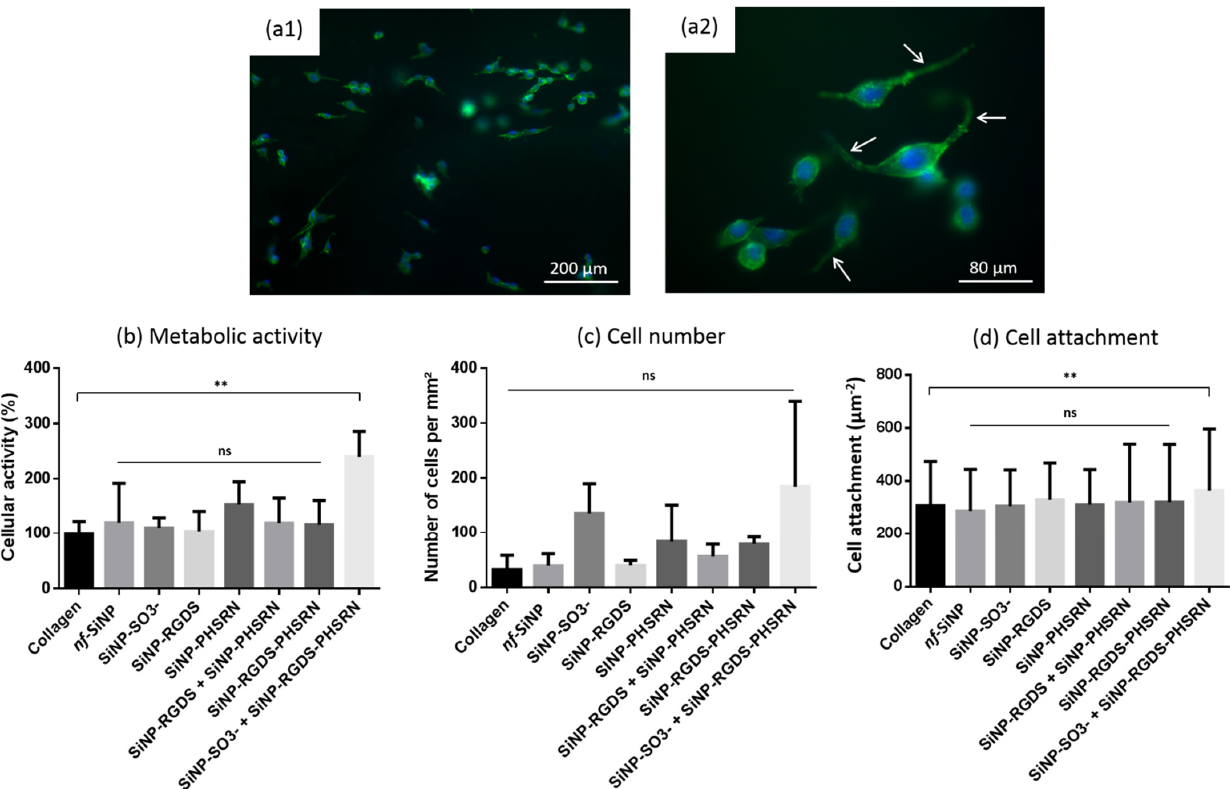
Figure 8. ( a1 , a2 ) Fluorescence microscopy images of 3T3 cells cultured for 24 h on magnetically-aligned collagen films. Actin (green: phalloidin) and nucleus (blue: DAPI) staining. White arrows show stress fibers. ( b ) Metabolic activity measured by Alamar blue assay. Statistical test realized using Mann-Whitney non parametric test; each condition issued from three independent experiments. ( c ) Cell number obtained by counting all cells on a 4 mm 2 composite surface. ( d ) Cell attachment obtained by measuring the projected areas of cells. Statistical tests for ( c , d ) realized using ANOVA (Dunnett) parametric test. Each column represents mean with SEM (ns _ non-significant _ p > 0.05; ** p ≤ 0.01).